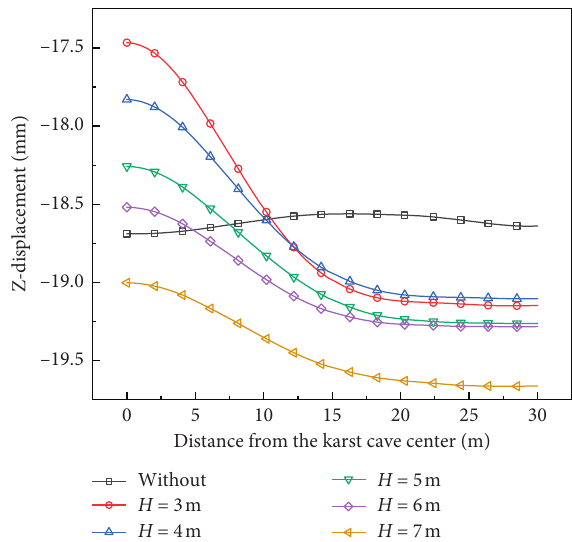
Figure 13: Z -displacement curves of the tunnel bottom with varying locations of the karst